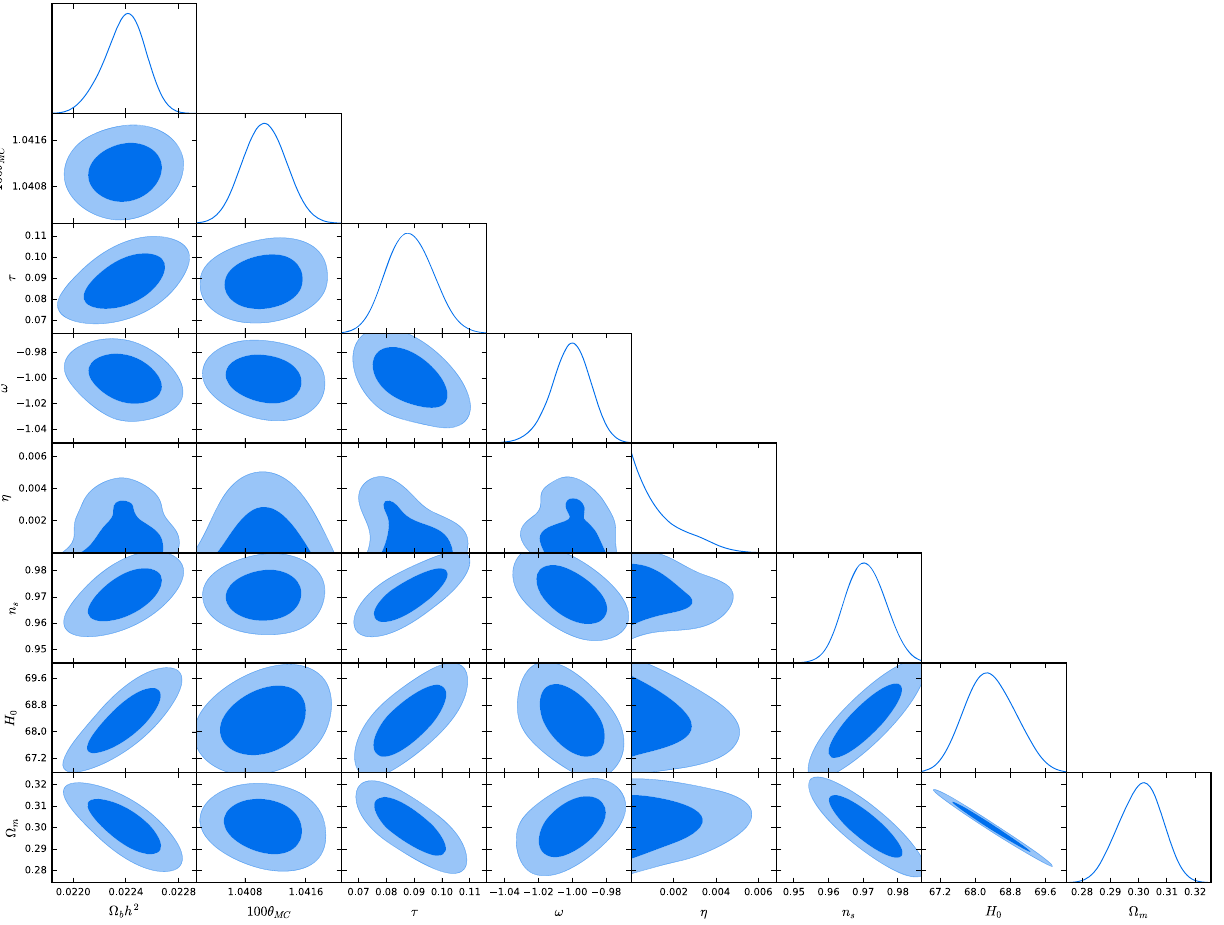
Fig. 6 The 1-dimensional posterior distributions on the individual parameters and 2-dimensional marginalized contours of the V (cid:4) DE model using the data combination